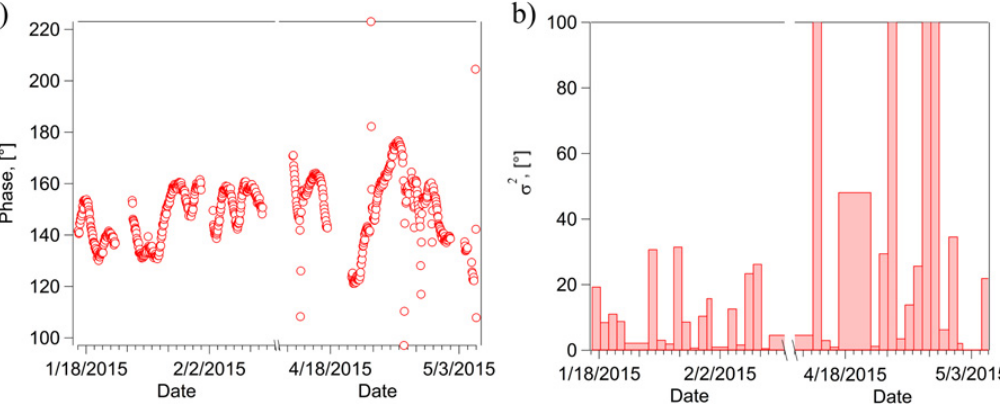
Figure 2. Phase data from a gaseous sample. (a) Phase data taken over a period of several months. Each point represents the fitted φ from Eq. (5) taken every 21 minutes. (b) The variance defined in Eq. (5) for the data in (a).